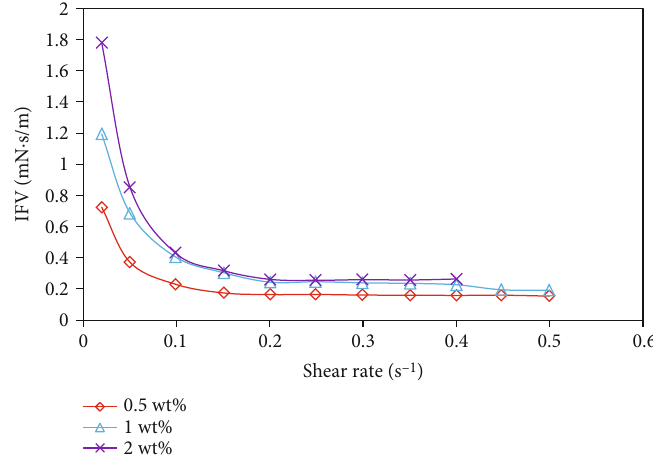
Figure 6: In fl uence of the asphaltene content on